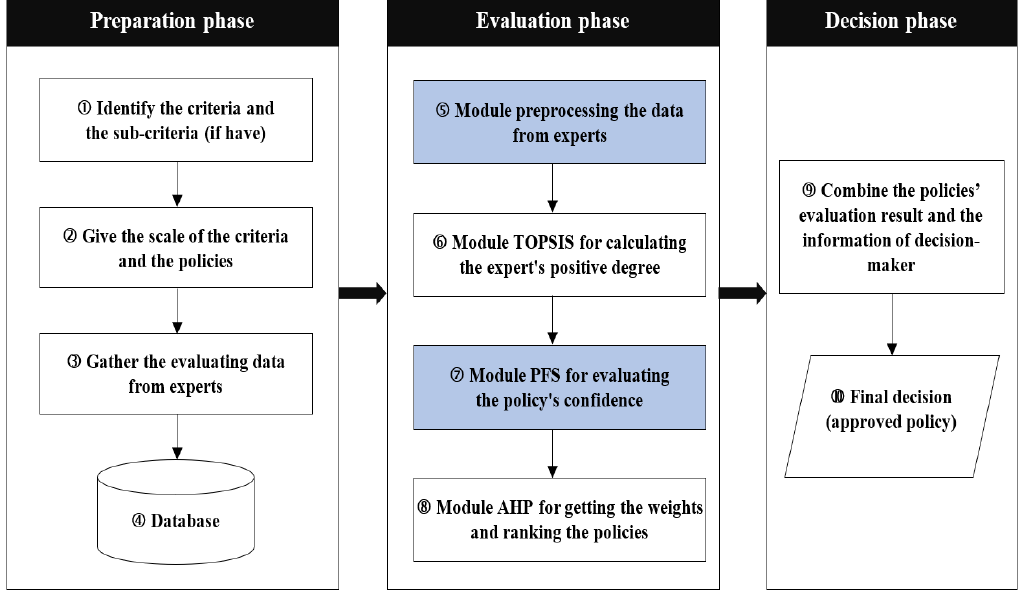
Figure 2. A novel PFS-TOPSIS-AHP model for evaluating policymaking under